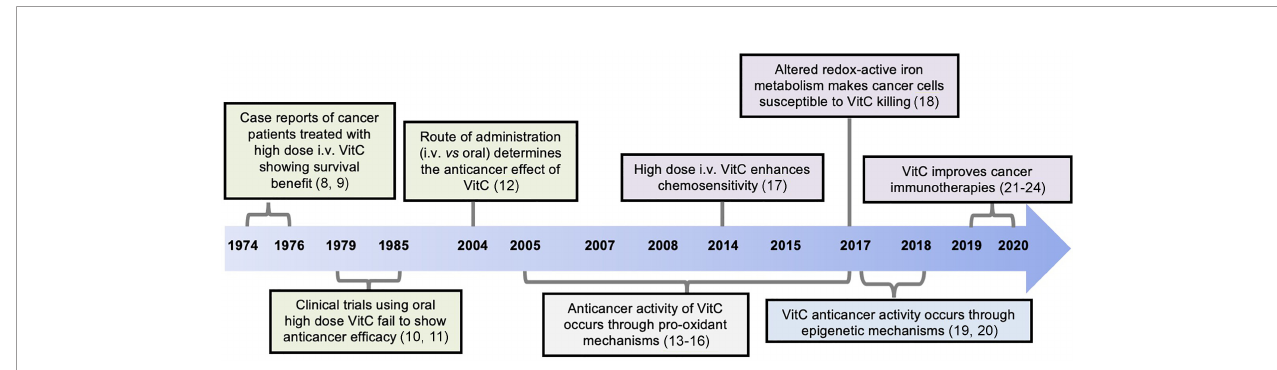
FIGURE 1 | Timeline of discoveries related to the anti-cancer function of Vitamin C (VitC). Advances made over past decades identi fi ed VitC as potential anti-cancer agent at high dose yielding remarkable clinical ef fi cacy when given intravenously, and not through oral administration. Mechanistically, VitC at high dose preferentially kills tumor cells in vitro or delays tumor growth in vivo by exerting pro-oxidant effects and by disrupting iron metabolism, as well as through modulation of epigenetic mechanisms mediated by TET enzymes. Numbers in brackets refer to corresponding